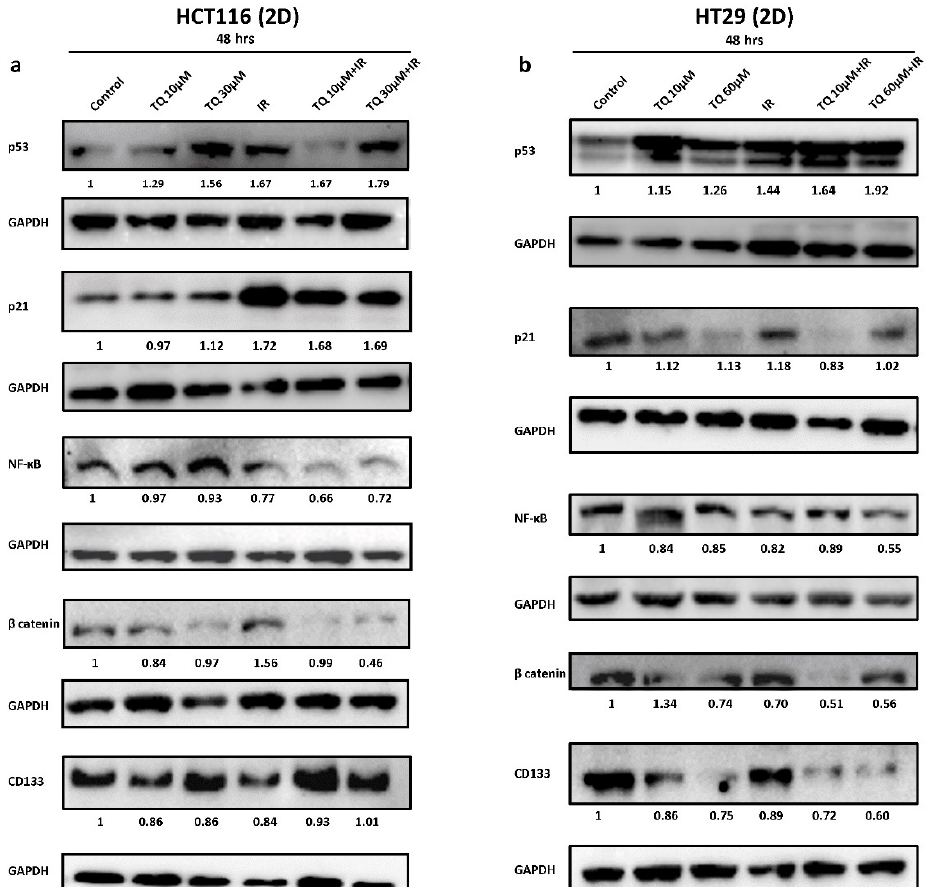
Figure 3. TQ sensitizes colorectal cancer cells to radiation through targeting major pathways impli- cated in radiation therapy. Western blot analysis of p53, p21, NF- κ B (p65), β catenin, and CD133 48 h post treatment with TQ, IR, or TQ+IR in HCT116 ( a ) and HT29 cells ( b ). Fold expression changes normalized to GAPDH. Data represent an average of at least three independent